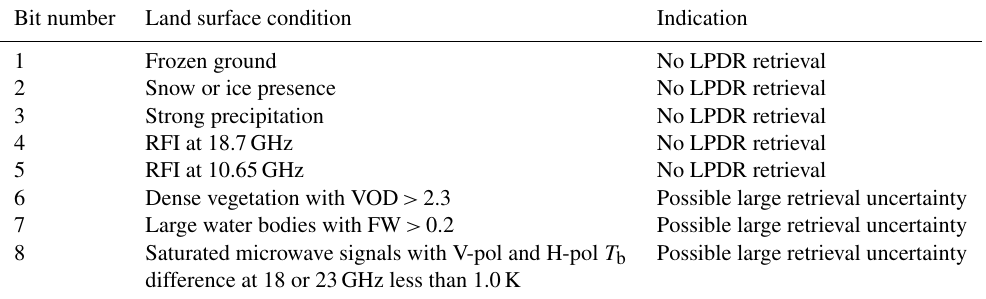
Table 5. LPDR data quality flag description. Bit number Land surface condition Indication